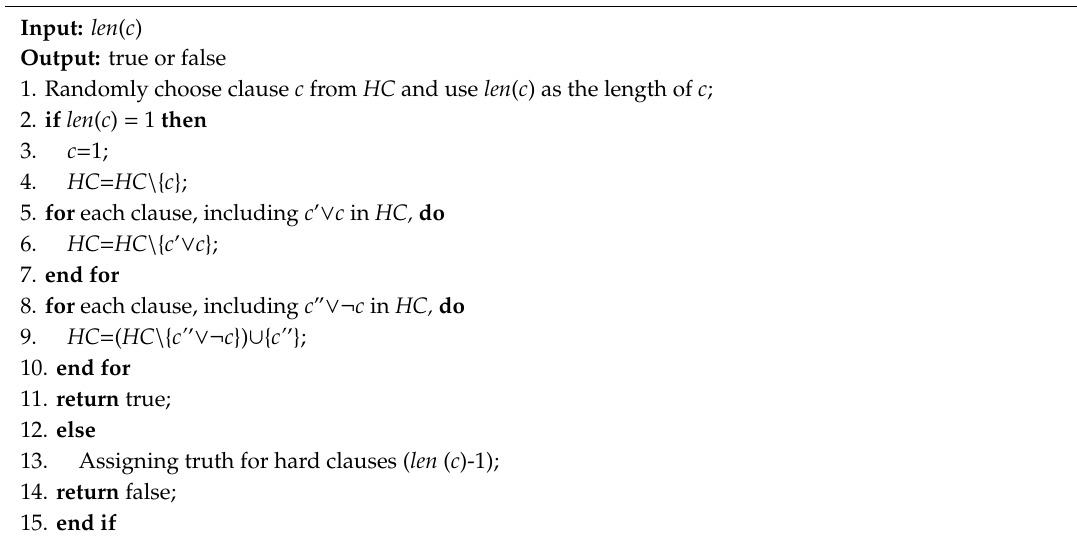
Algorithm 6. Assigning truth for hard